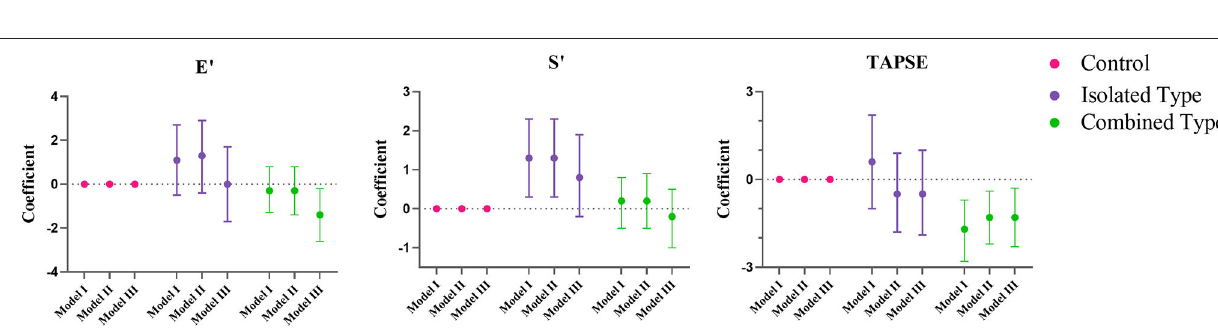
FIGURE 2 | Multiple regression analysis of left ventricular echocardiographic variables between control, isolated MMA and combined MMA patients. Multiple regression analysis was used with control group as reference. Model I was not adjusted, model II was adjusted for age, gender and BMI Z score, and model III was adjusted for age, gender, BMI Z score, blood pressure and heart rate. LVIDD, left ventricular internal diastolic diameter; LVIDS, left ventricular internal systolic diameter; EF, ejection fraction; FS, fractional shortening; LVM, left ventricular mass; LVMI, left ventricular mass index; E/A, ratio of early and late diastolic mitral inflow velocity; E’, peak early diastolic velocity; GLS, global longitudinal strain.